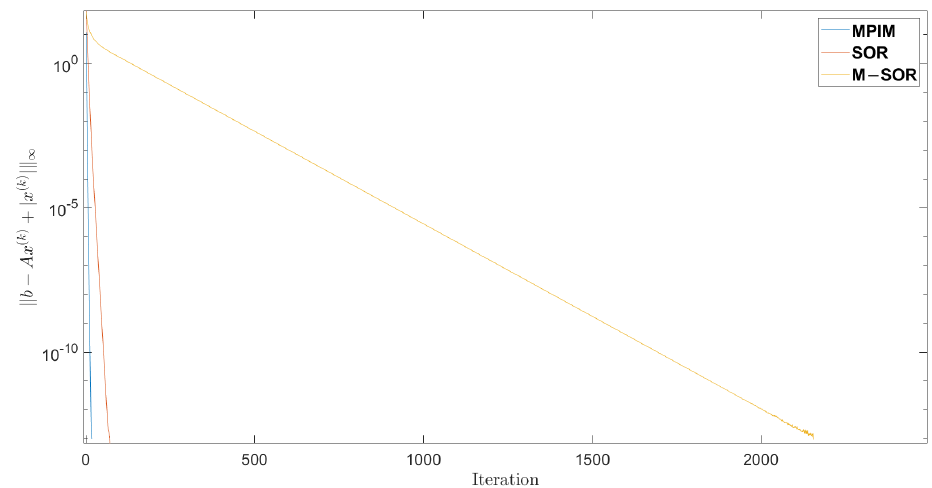
Figure 1. Number of iterations.